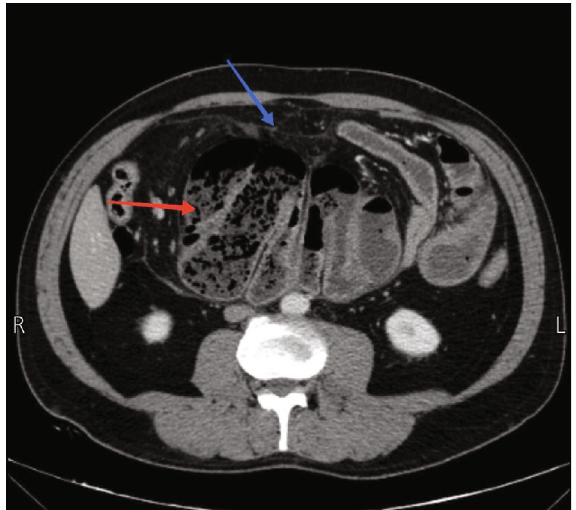
Figure 1: Axial image of contrast enhanced CT shows cluster of small bowel (red arrow) which encapsulated by peritoneum (blue arrow).